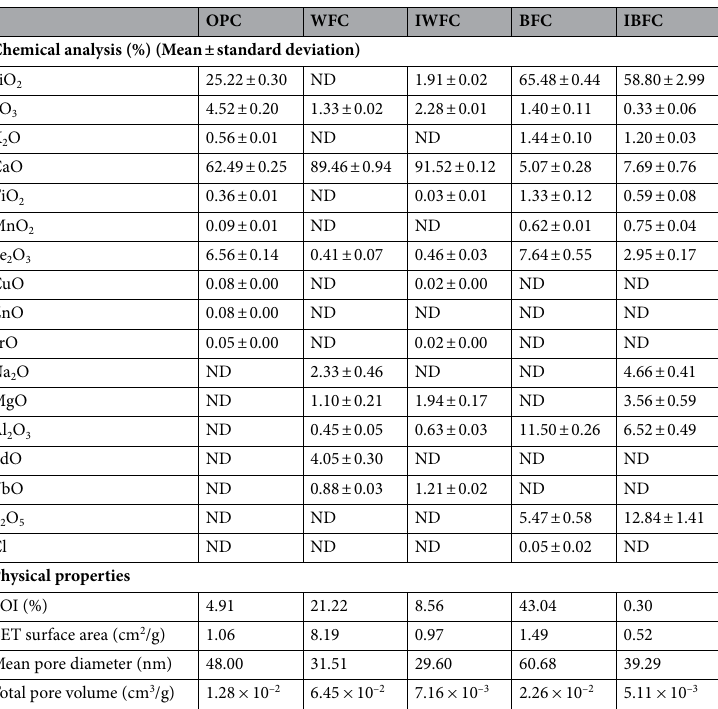
Table 2. Chemical compositions and physical properties of the OPC (ordinary Portland cement); WFC (White filter cake); IWFC (Incinerated white filter cake); BFC (Black filter cake) and IBFC (Incinerated black filter cake). Chemical compounds that are not detected are denoted as ND (not